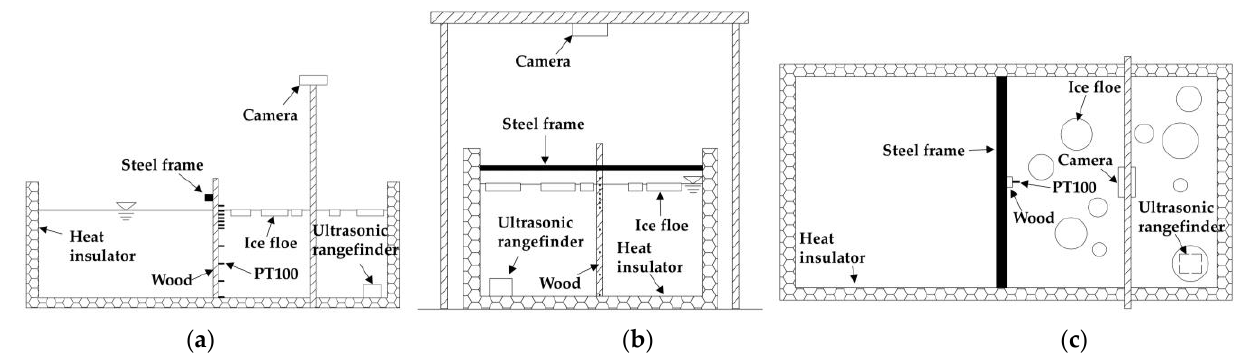
Figure 2. The laboratory equipment setup. ( a ) Front schematic; ( b ) lateral schematic; and ( c ) top schematic.